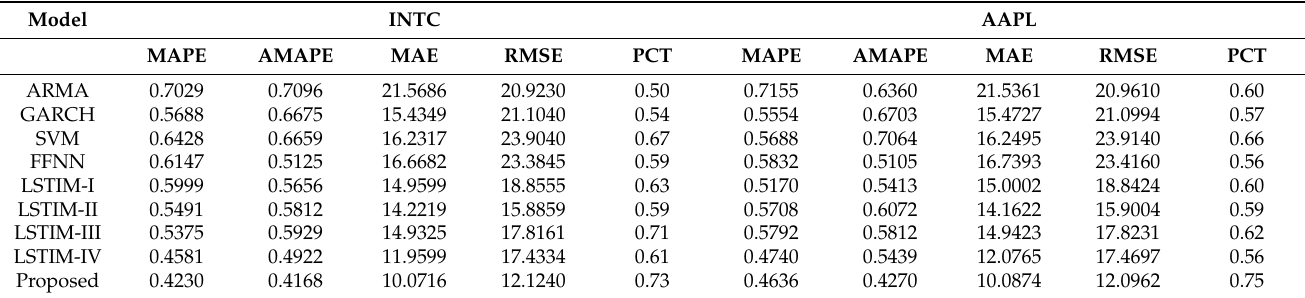
Table 10. Prediction performance for 150 days: INTC and AAPL.